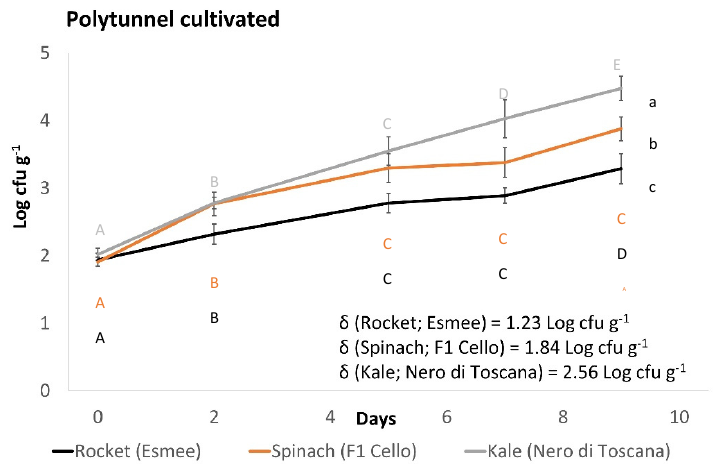
Figure 2. Growth of L. monocytogenes (100 cfu g − 1 initial inoculum) on polytunnel produce: rocket (Esmee) (black line), spinach (F1 Cello) (brown line) and Kale (Nero di Toscana) (grey line). Incubated at 7 °C for (6 days) followed by 12 °C (3 days). (±) error bars indicate standard deviation; δ represents growth potential value for each batch; letters a–c indicate significant differences in L. monocytogenes growth; letters A–E indicate significant differences over time for rocket (black), spinach (brown), and kale (grey).